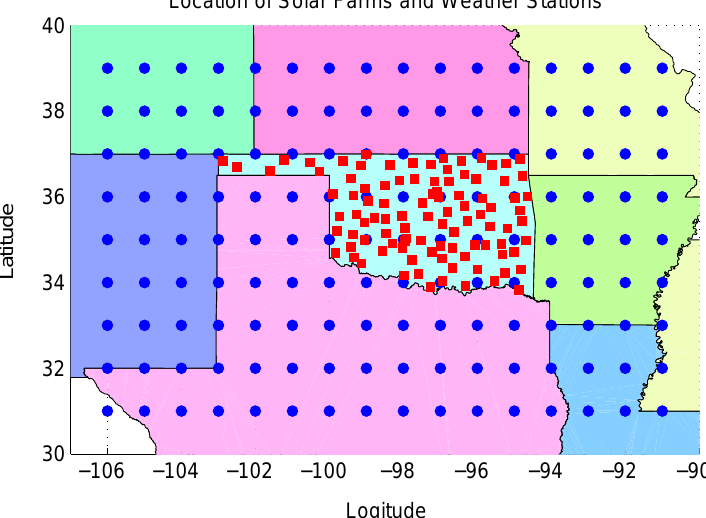
Figure 1. Grid points where NWP (numerical weather prediction) is forecasted are plotted as blue circles. Red squares represent candidate solar farms, which are all located in Oklahoma